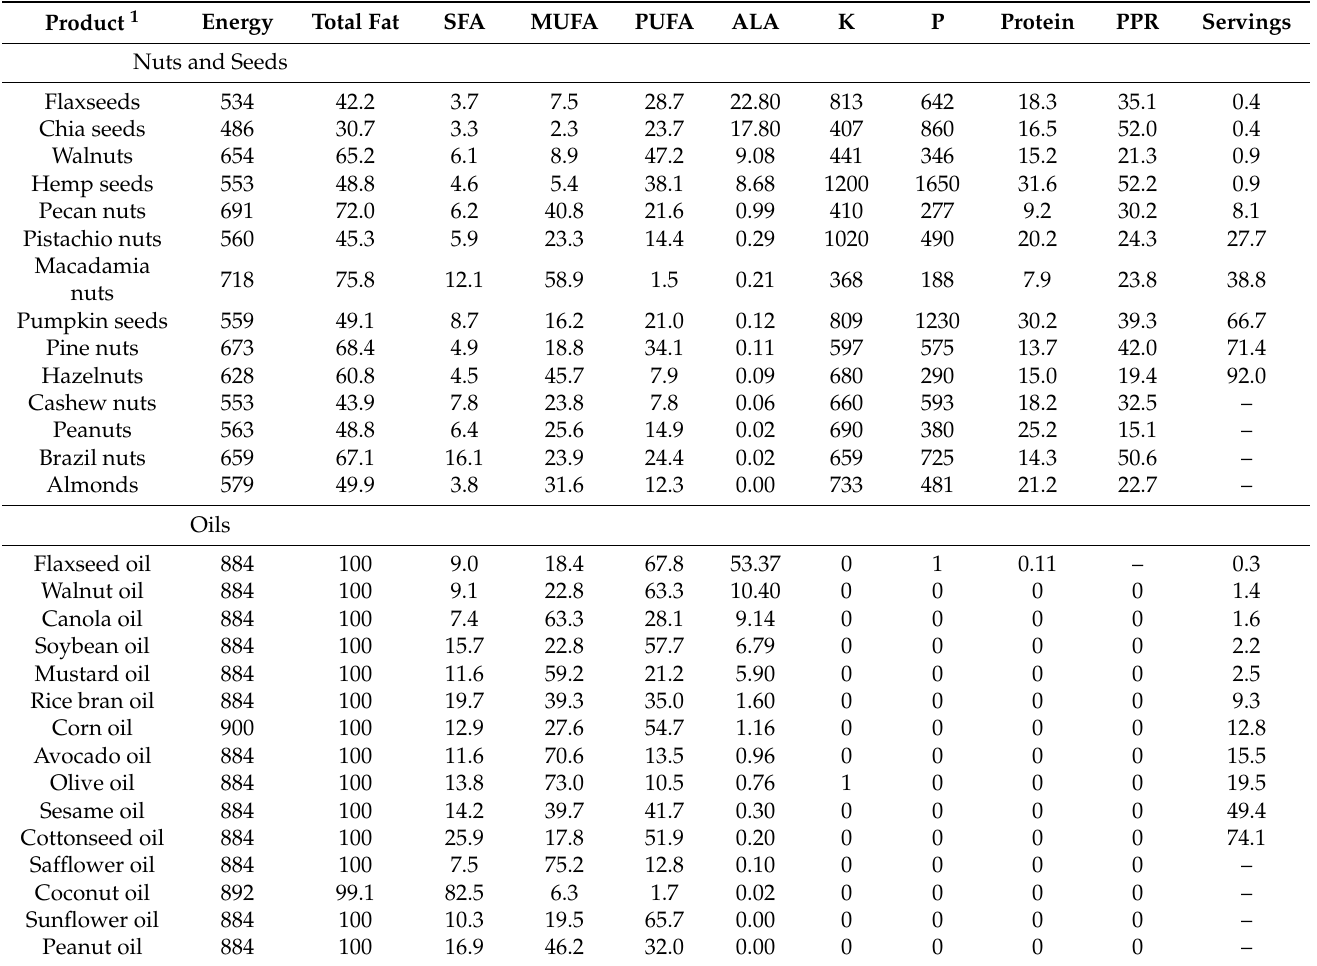
Table 1. Nutritional composition of nuts, seeds, and vegetable